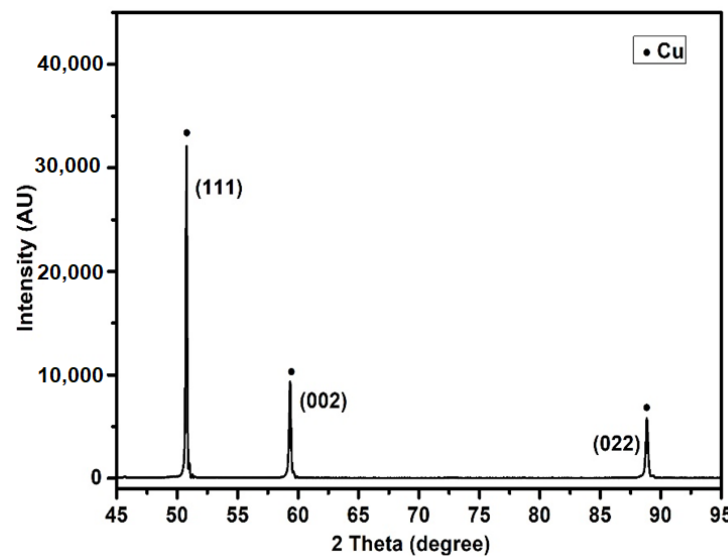
Figure 2. XRD pattern of separated metal clads of WPCBs.